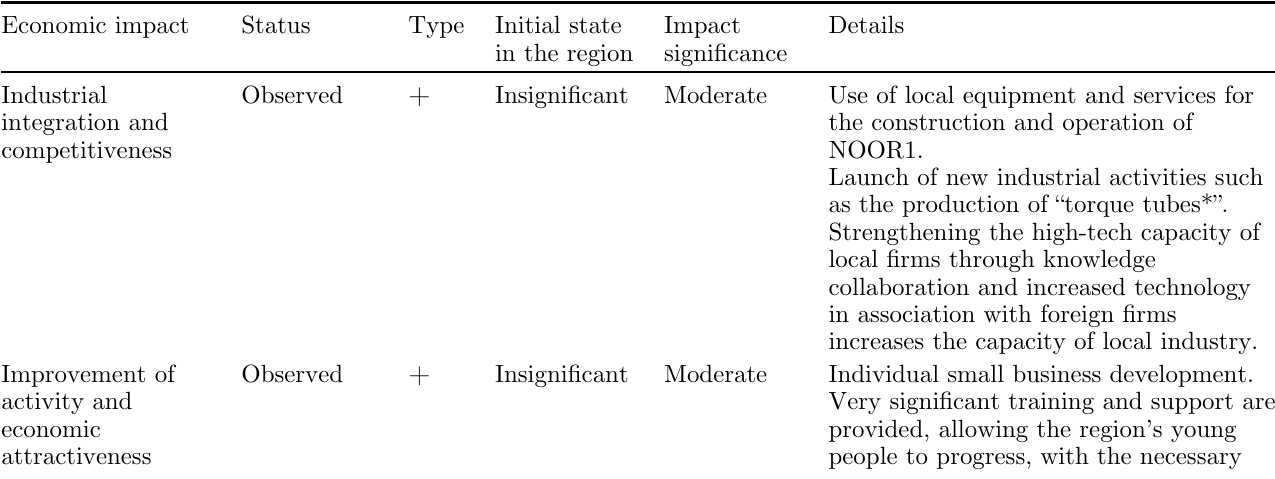
Table 2. Review of results related to the economic impact of NOOR 1 on the S outhern